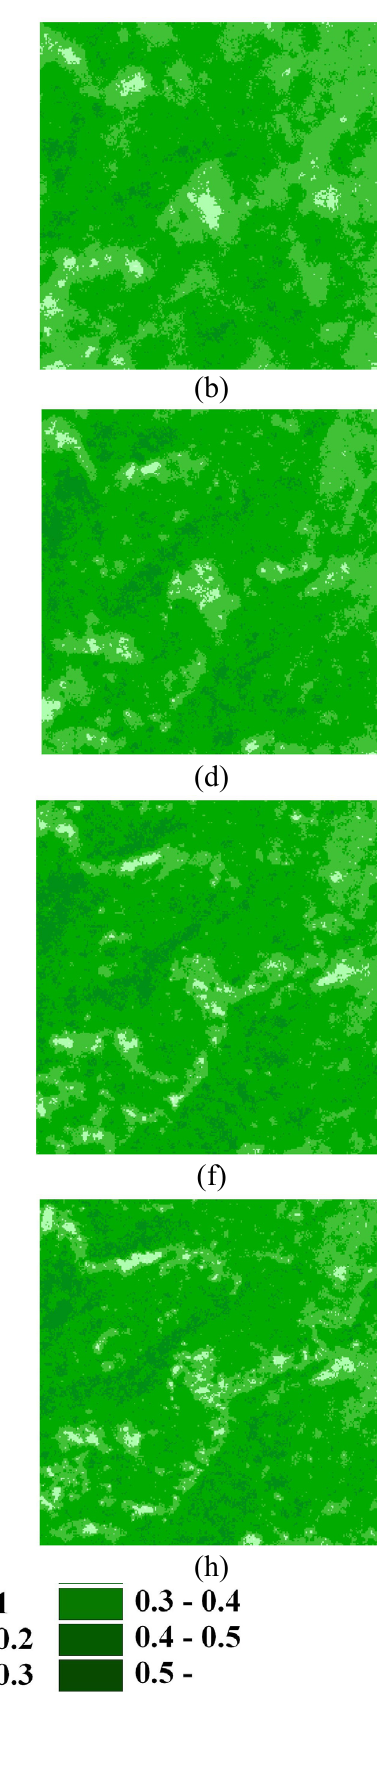
Figure 7 . SGS simulated NDVI images based on (a) 100, (b) 500, (c) 1,000, (d) 2,000, (e) 3,000, (f) 5,000, (g) 7,000, (h) 10,000 on